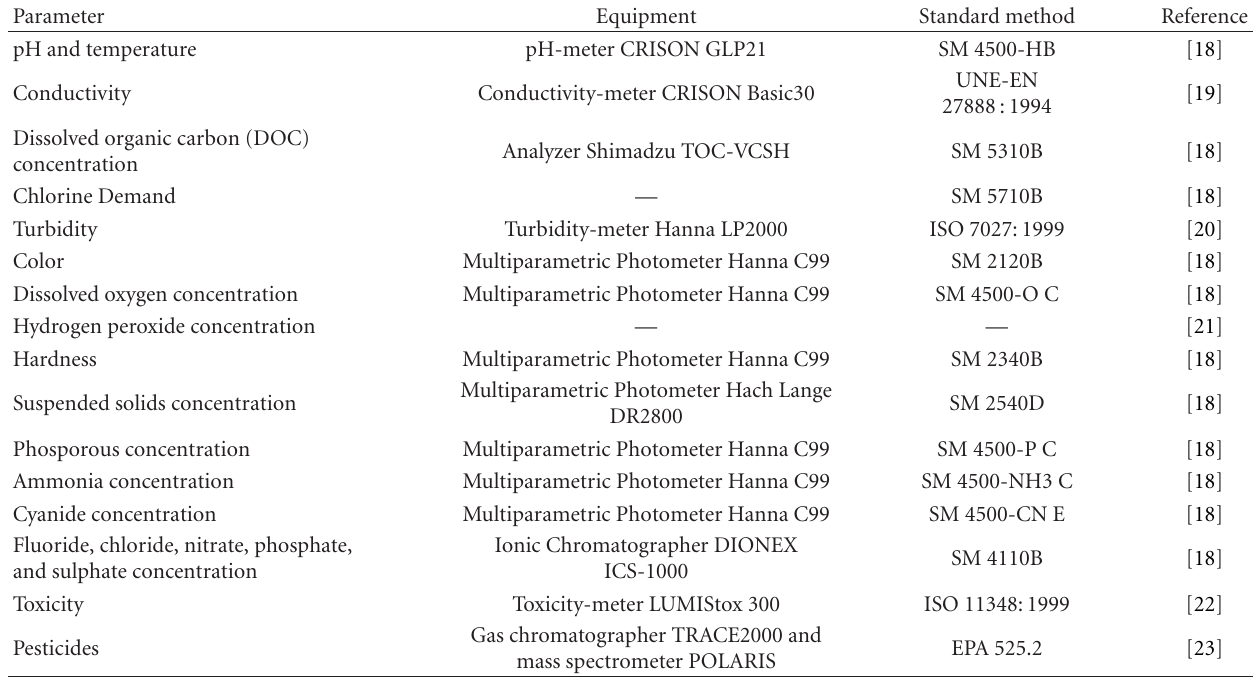
Table 1: Parameters, equipment, and standardized methods used for the characterization of samples.